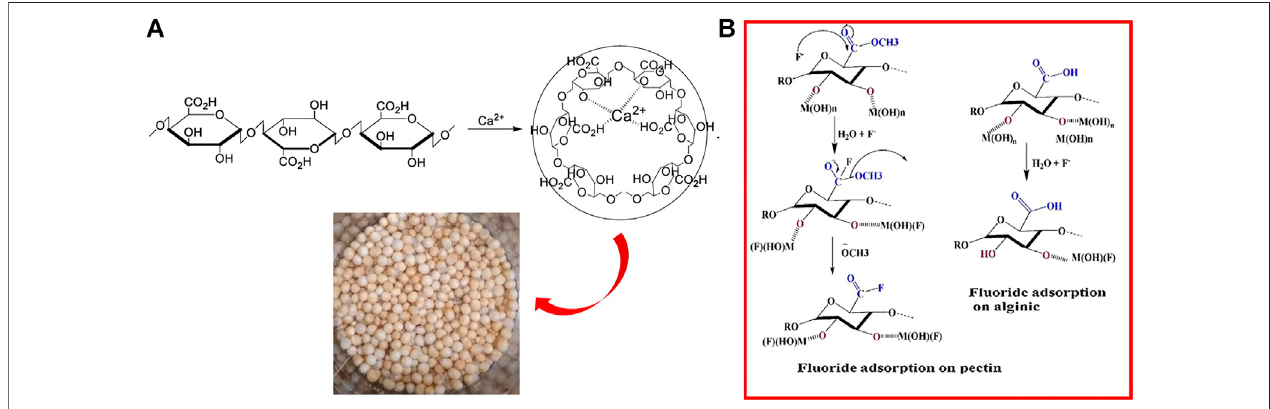
FIGURE 2 | Ioniccross-linking procedure ofsodium alginate (A) (Sharmaet al., 2019) and fl uorideadsorption mechanism of pectin (B) (Raghav and Kumar 2019).